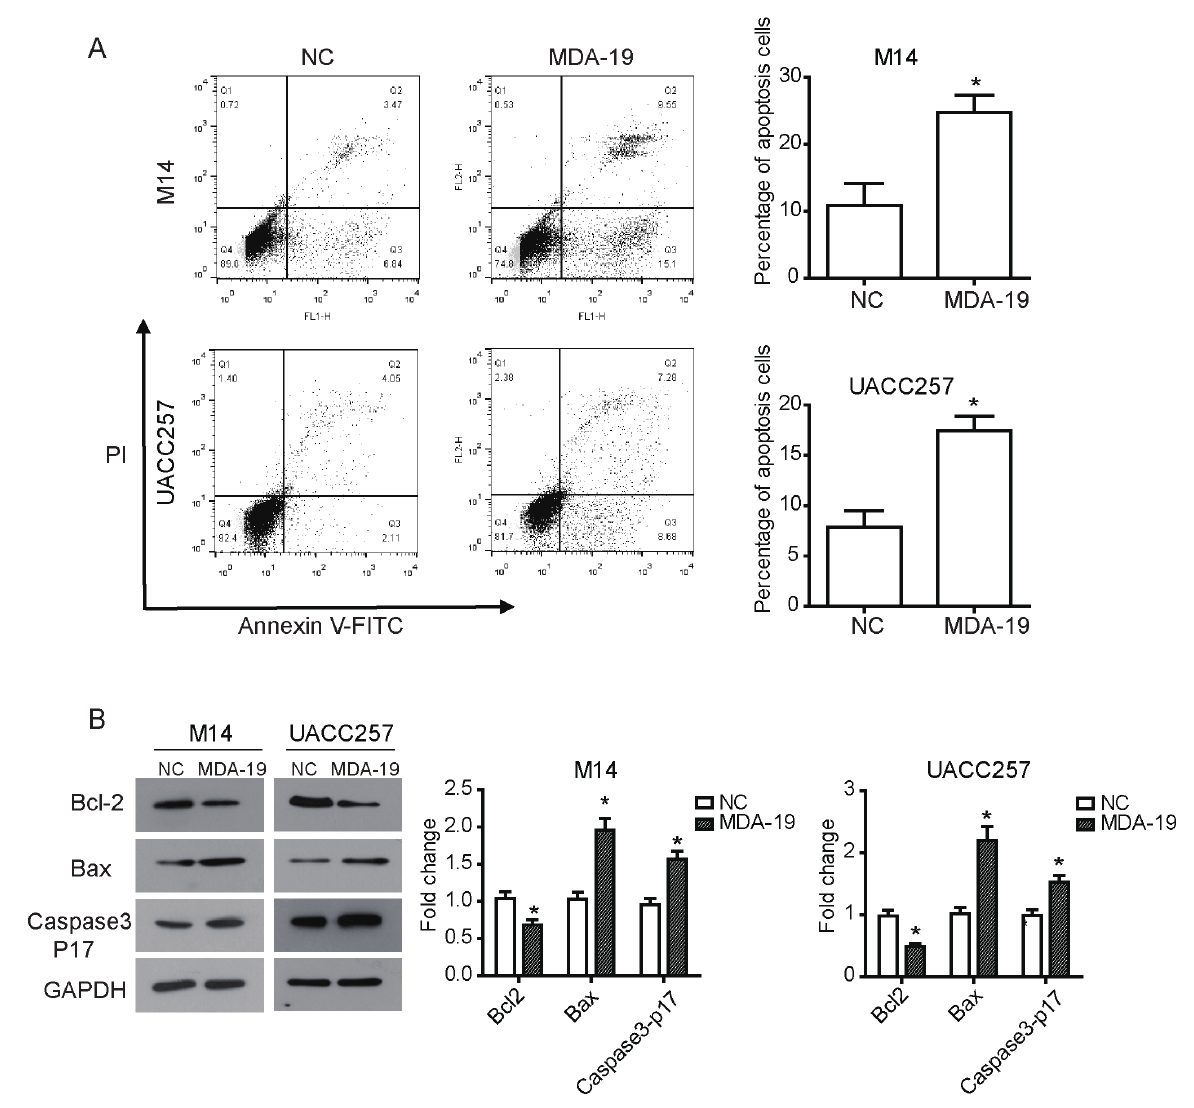
Figure 4: MDA-19 induces apoptosis of melanoma cells in vitro. M14 cells was treated with 20 μM of MDA-19, and UACC257 cells was treated with 10 μM of MDA-19. (A) After treatment with MDA-19 for 24h, flow cytometry assay was performed to detect cell apoptosis in M14 cell (upper) and UACC257 cell (below) using Annexin V-FITC- PI apoptosis detection kit. (B) After treatment with MDA-19 for 48h, Western blot was used to examine expression of related proteins in M14 cell (left) and UACC257 cell (right). The results showed that expression of Bcl-2 was decreased by MDA-19, expression of Bax and Caspase3 P17 were significantly up-regulated. Data are expressed as the mean ± SD. MDA-19: MDA-19 treated group; NC: DMSO treated group, negative control.